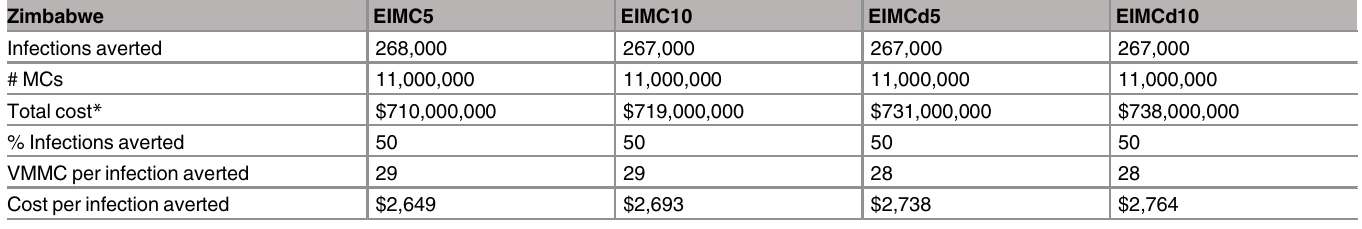
or increase the costs. Table 5. Cost and Cost-effectiveness of EIMC Start-up, by